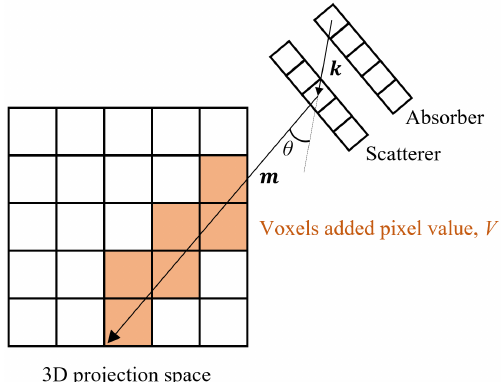
Figure 5. Simple back-projection method: let k be the vector connecting the interacting elements on the absorber and scatterer layers, and m the vector connecting the interacting element on the scatterer and the voxels in projection space. The pixel value of the voxels, depicted in orange, can be calculated using the delta function in Equation